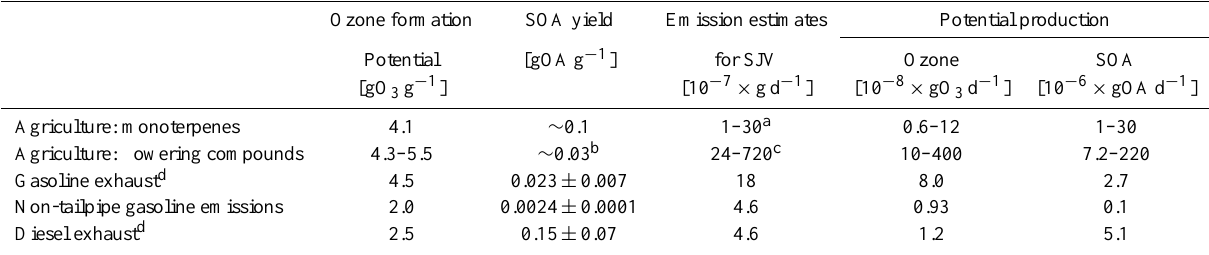
Table 8. Metrics of secondary pollutant formation, emissions, and potential impacts of biogenic emissions from agricultural crops compared to motor vehicles in California’s San Joaquin Valley. Ozone formation SOA yield Emission estimates Potential production Potential [gOAg − 1 ] for SJV Ozone SOA [gO 3 g − 1 ] [10 − 7 × gd − 1 ] [10 − 8 × gO 3 d − 1 ] [10 − 6 × gOAd − 1 ]